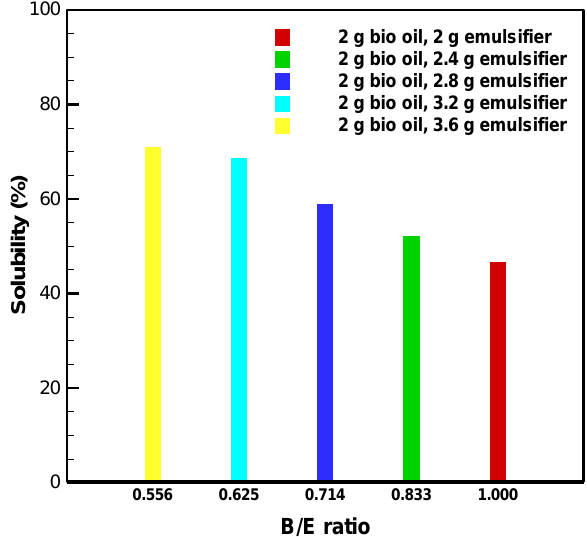
Figure 8. The solubility of bio-oil at different B/E ratios with 1 g methanol.